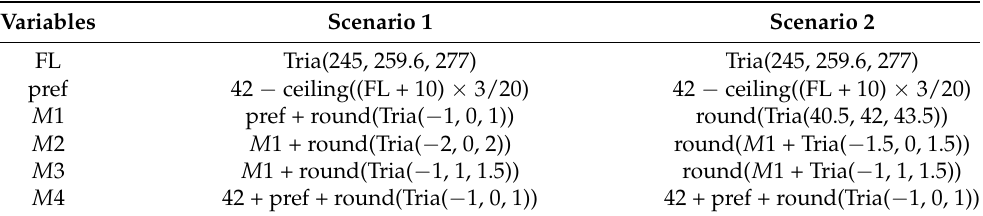
Table 1. The variables are sampled independently from the following distributions. Tria(a, c, b) stands for the triangular distribution, with values in [ a , b ] and mode in c ; ceiling returns the smallest integer not less than the corresponding element; and round rounds the